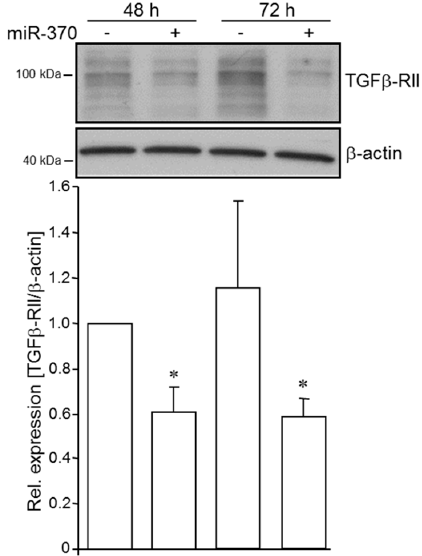
Figure 2. Ectopic expression of miRNA-370-3p in PDAC cells decreases the abundance of TGF β -RII. Panc1 cells were transfected with 50 nM of an artificial miR-370-3p (miRNA-370-3p mimic) for the indicated periods of time. The levels of TGF β -RII were analysed by Western blotting in whole cell lysates. Detection of β -actin served as a loading control. The graph underneath the blot shows results from densitometric quantification of band intensities from three independent experiments (mean ± SD, n = 3). The asterisks ( * ) indicate significance ( p < 0.05) relative to respective untreated control.